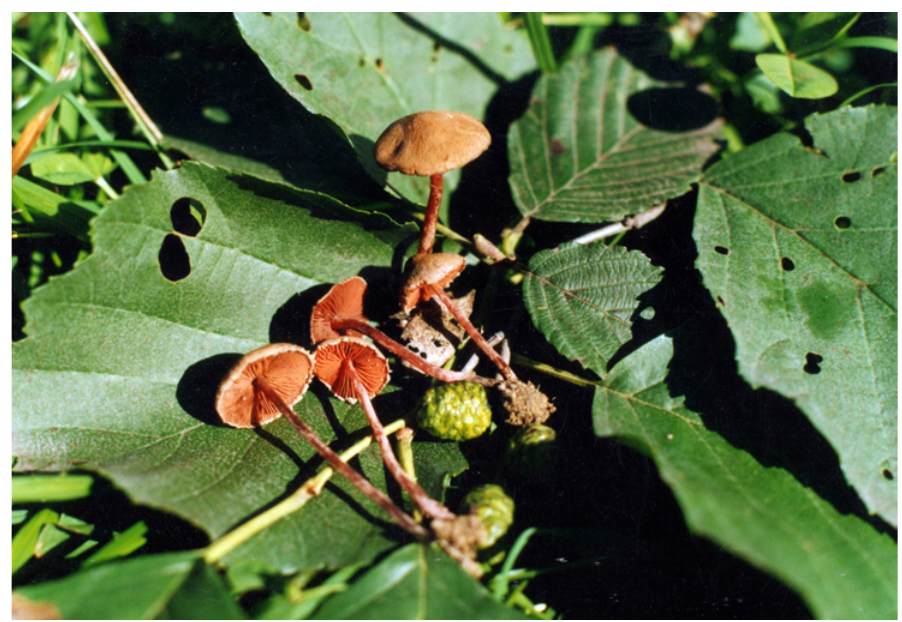
Fig. 3. Melanophyllum haematospermum growing on humus rich soils of the frondose forests (Phot. A.